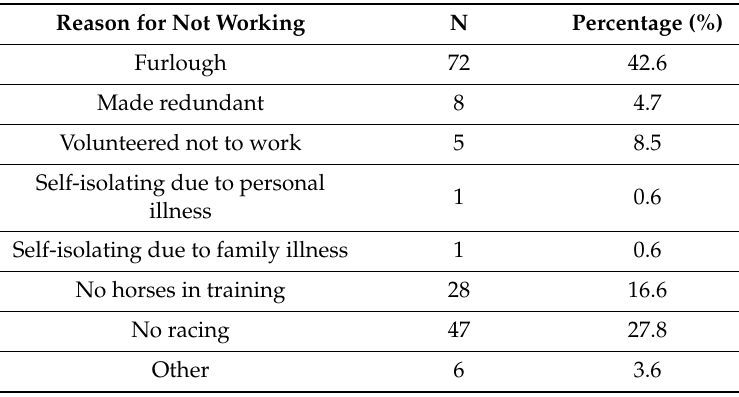
Table 4. Reasons for not working during